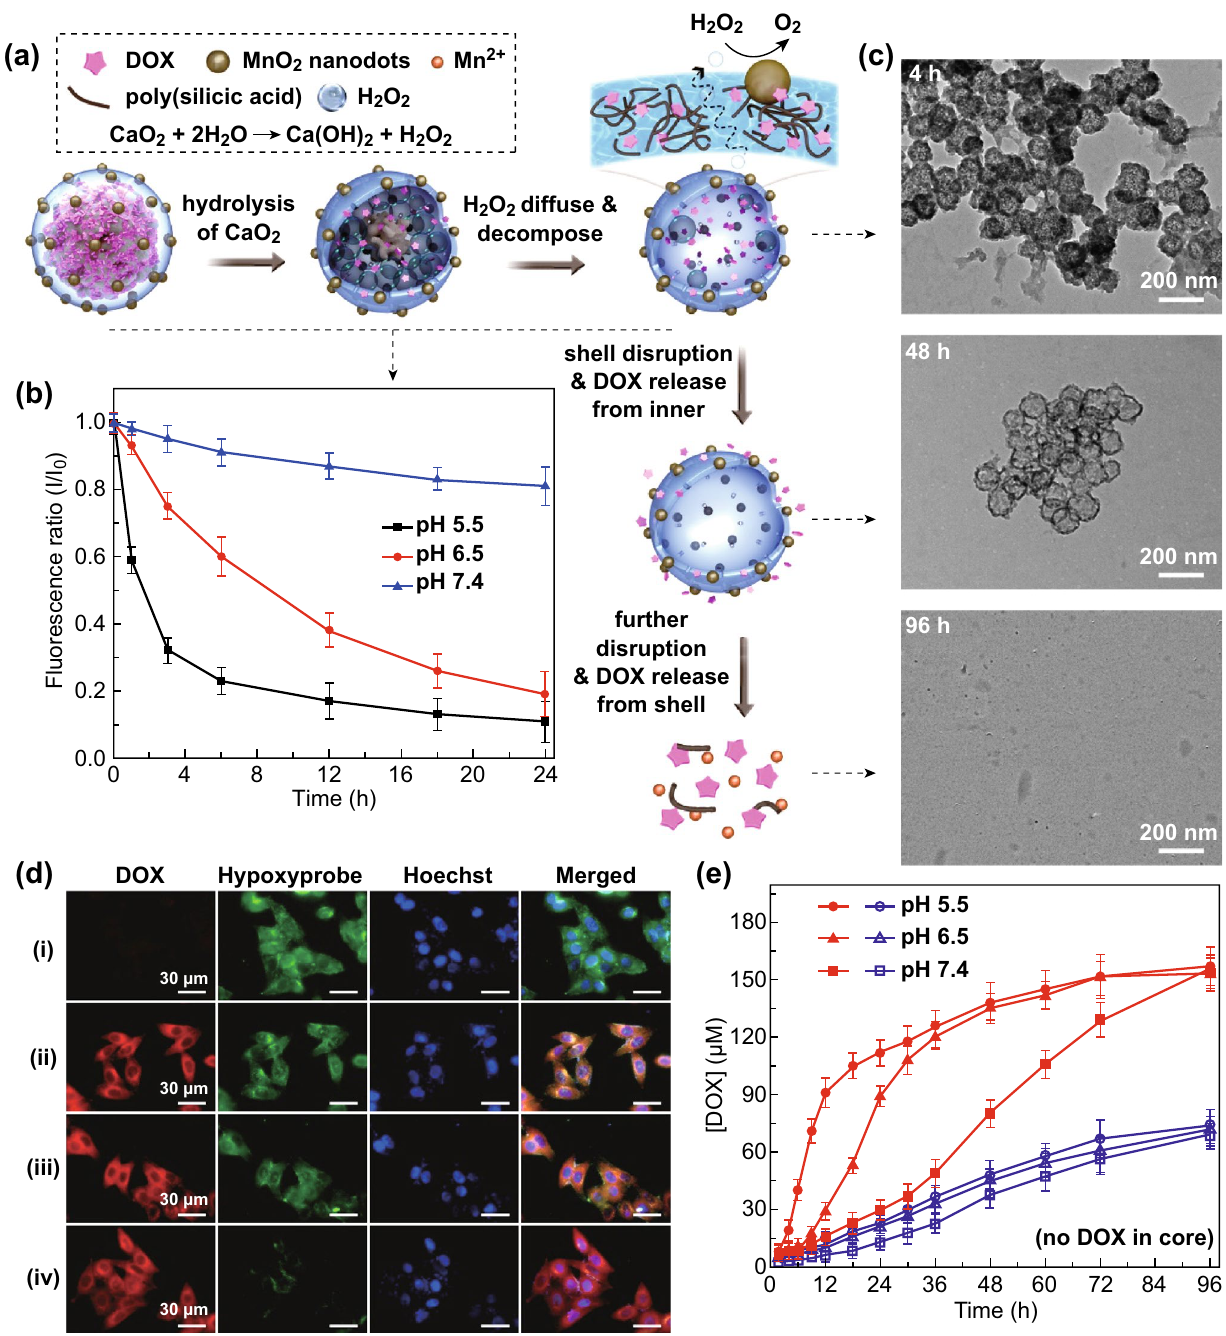
Fig. 2 a Schematic illustration of the processes of oxygen generation, DOX release and decomposition of NRs. b The measurement of oxygen release process of CDSDM NRs, shown as the ratio of fluorescence intensity of Ru(dpp) 3 Cl 2 (an oxygen indicator) after incubated with NRs for different durations ( I ) to that before incubation ( I 0 ). c TEM images of the decomposition process of CDSDM NRs after incubated in pH 5.5 PBS for different durations. d Representative CLSM images of B16F10 cells from hypoxia cultivation after co‑incubated with (1) PBS, (2) hDSDM NPs, (3) CDSD (without MnO 2 nanodots) NPs and (4) CDSDM NRs for 4 h. Hypoxia level was detected using Hypoxyprobe. e DOX release from CDSDM NRs and CSDM NRs in PBS of different pH